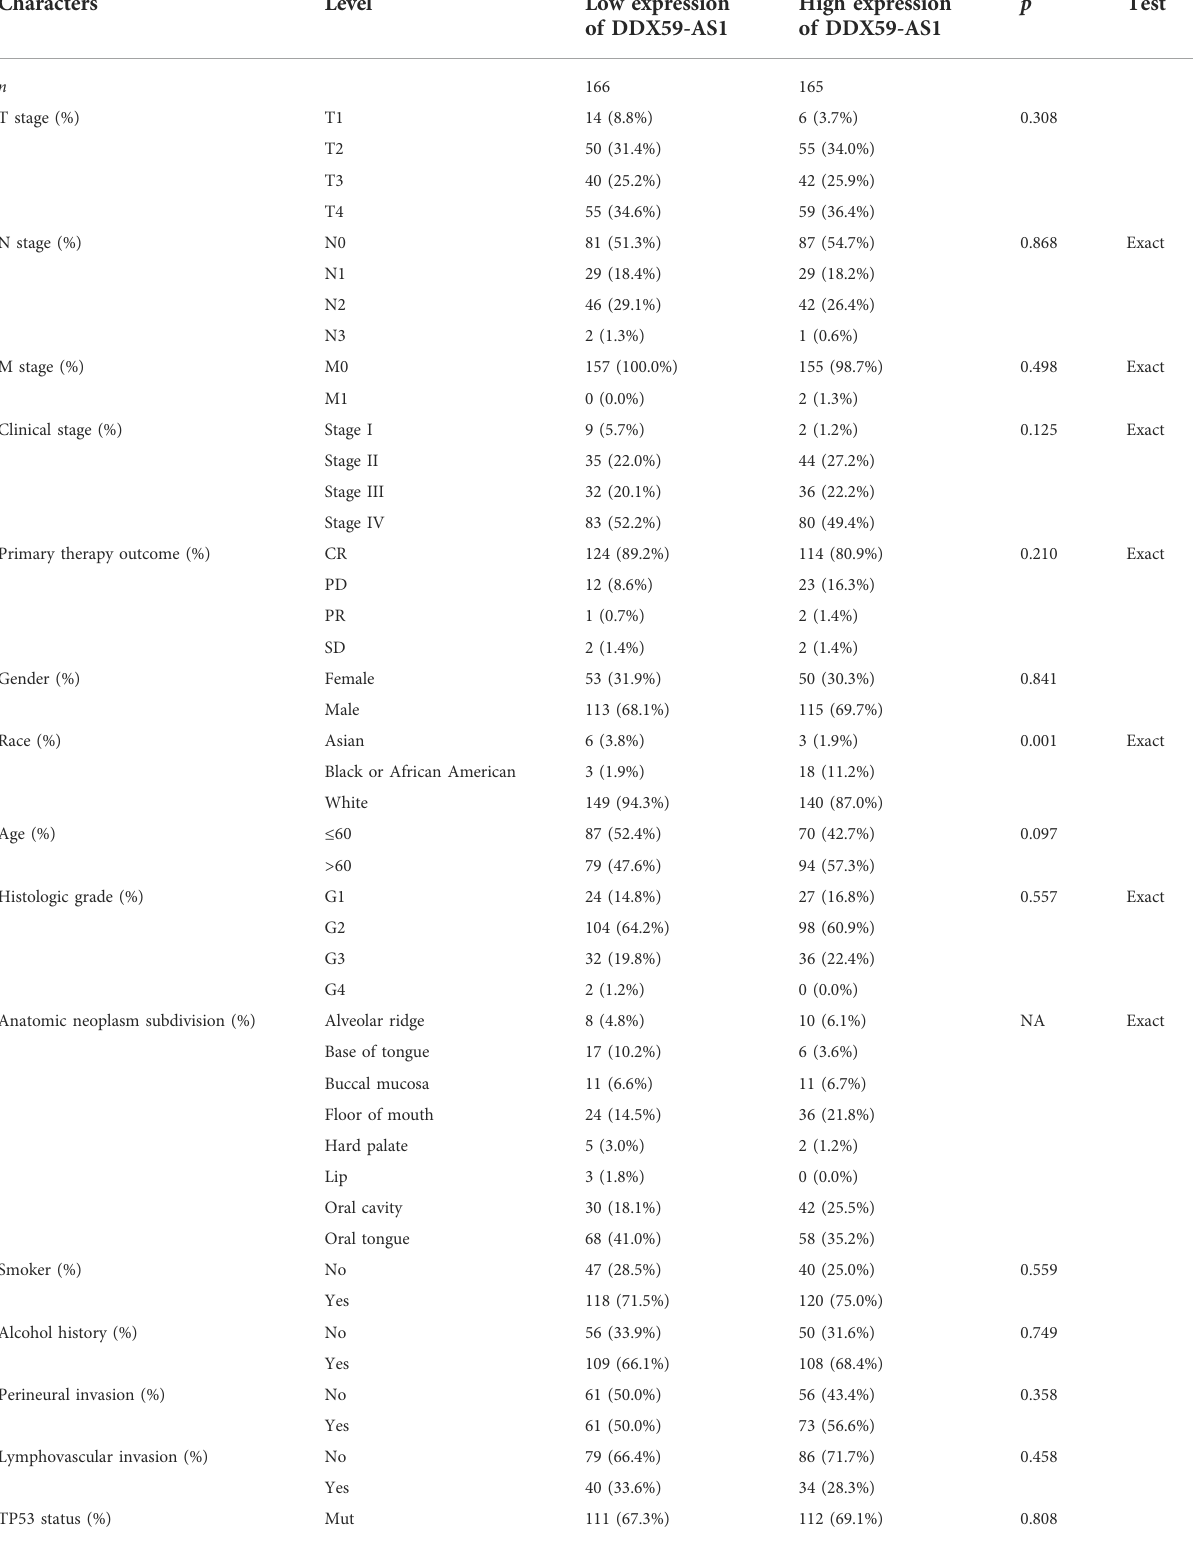
TABLE 1 Clinicopathological characteristics of OSCC patients with differential DDX59-AS1